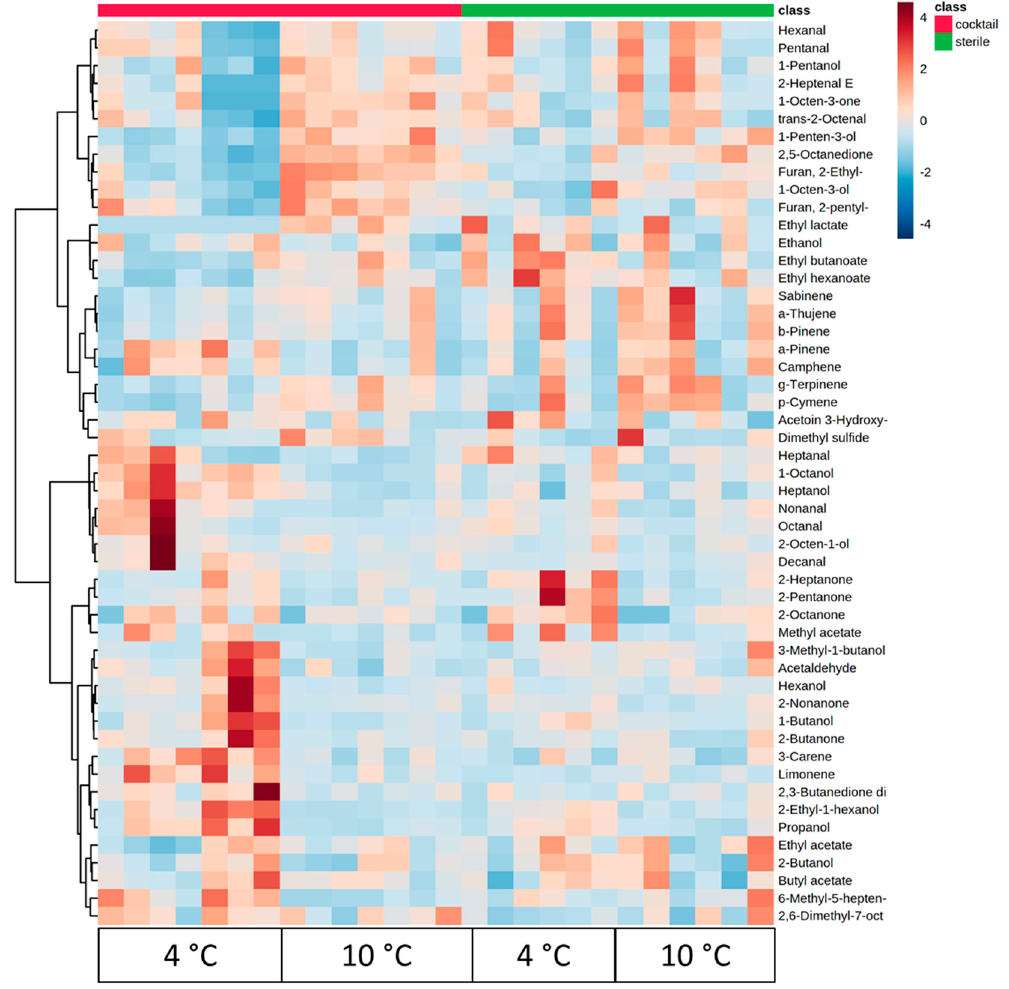
Figure 3. Hierarchical clustering result shown as a heatmap of volatiles associated with the group of sterile meat (green) and meat inoculated with the cocktail of all cultures (red) during storage at 4 and 10 °C. Ward-linkage clustering was based on the Euclidean correlation coefficients of the 51 volatiles identified in the different meat samples. The color scale represents the scaled abundance of each variable, with red indicating high abundance and blue indicating low abundance.